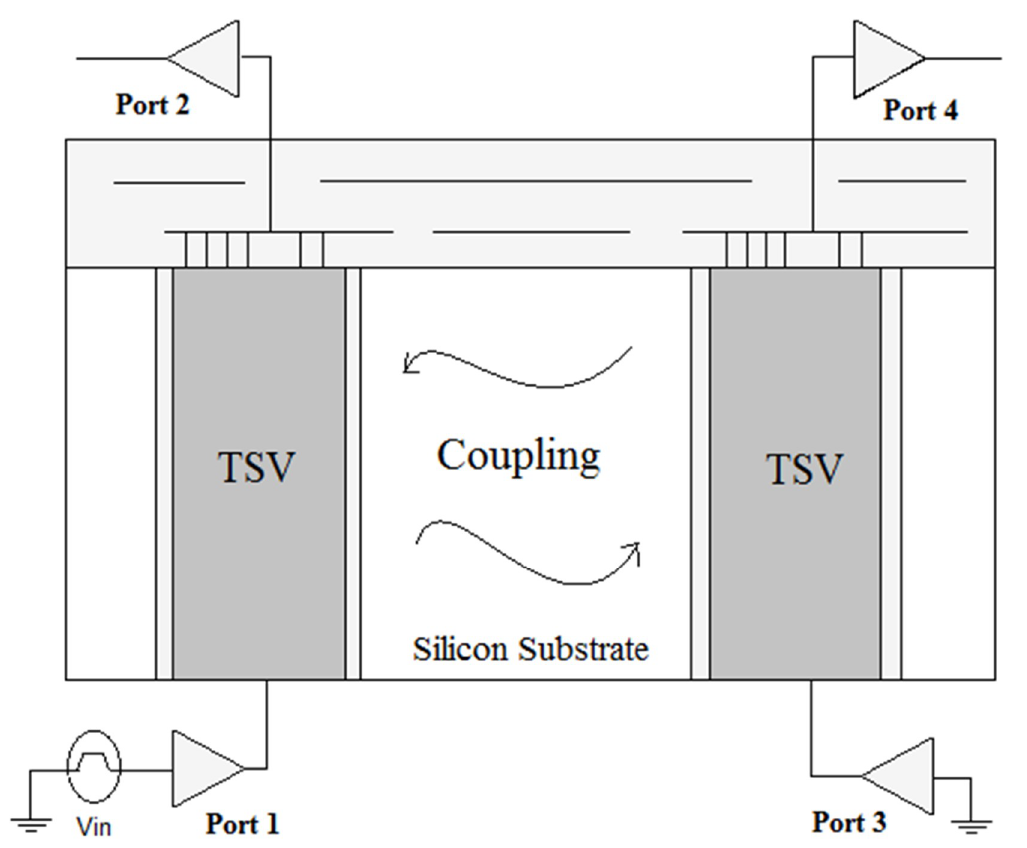
Figure 1. The through-silicon via (TSV)–TSV noise coupling structure with I/O termination.